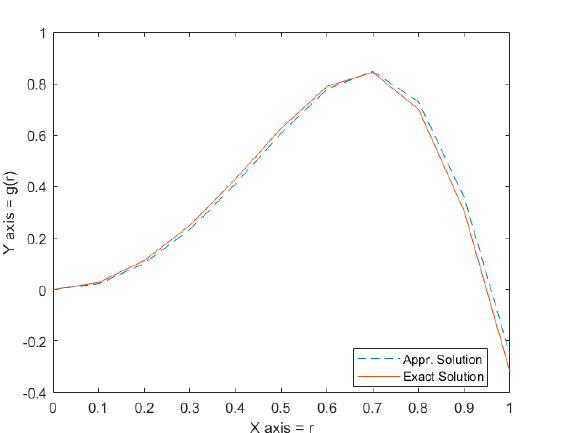
Figure 1. Graph of the comparison between an approximation and exact solution with h =